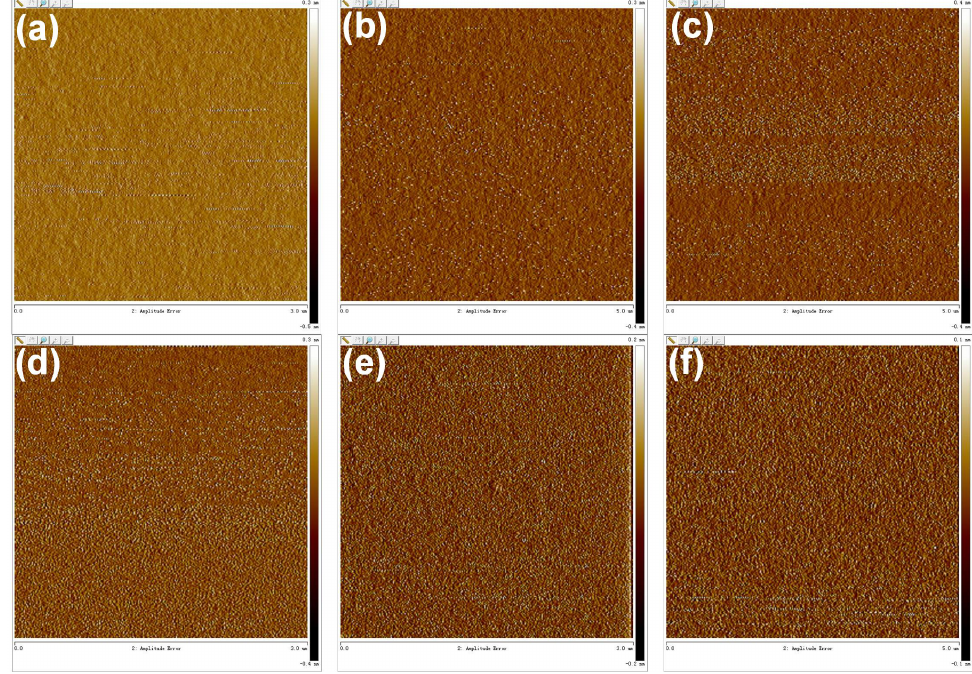
encoded into 1. The largest direction number combination is {8, 7}, which is encoded into Figure 1. The basic idea of our proposed TFD method for palmprint recognition. We first extract and Figure 1. AFM images of the composite films containing 5 wt. % azobenzene and heated at different 62. Figure 2 illustrates the basic idea of the robust texture feature extraction scheme. encode the triples types of features of a palmprint image, including the texture, gradient and direction temperatures of ( a ) 50, ( b ) 100, ( c ) 200, ( d ) 300, ( e ) 400 and ( f ) 500 ◦ C. features. Then, we form histogram-based feature vectors as the palmprint feature descriptors. Finally, we employ the weighted matching score fusion for feature matching and recognition.